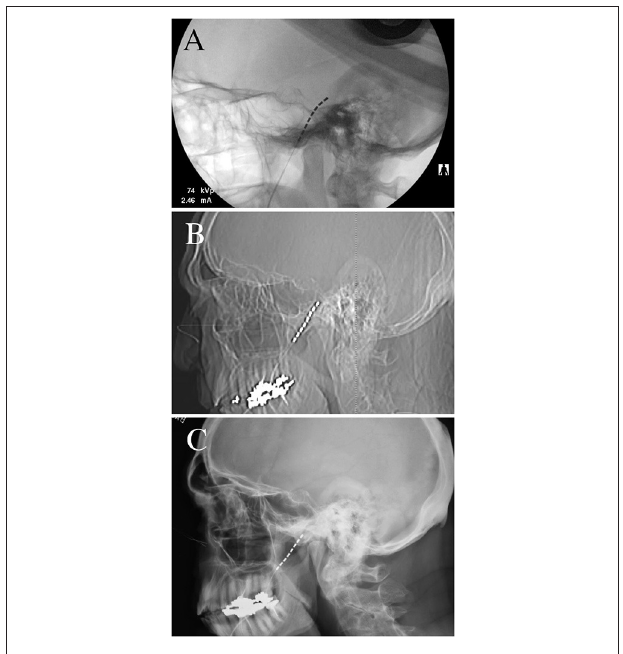
FIGURE 1 | Radiographs of trial electrode placement. (A) Intra-operative lateral skull fluoroscopy image demonstrating placement of the electrode with the most distal contact within the foramen ovale. (B) Immediate postoperative lateral skull radiograph demonstrating that two-thirds of the electrode had migrated outwards ( ∼ 35mm) (C) 10-day postoperative lateral skull radiograph demonstrating complete migration of the trial electrode out of the foramen ovale, with no electrode contacts adjacent to the trigeminal